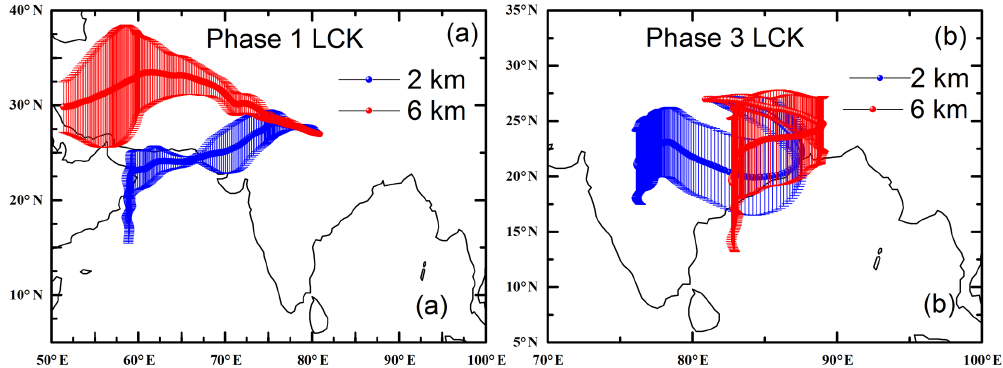
Figure 4. Back-trajectories showing the distinct air masses reaching Lucknow during the (a) pre-monsoon period and the (b) monsoon. The altitude indicates the height above sea level at which the air mass reaches the receptor